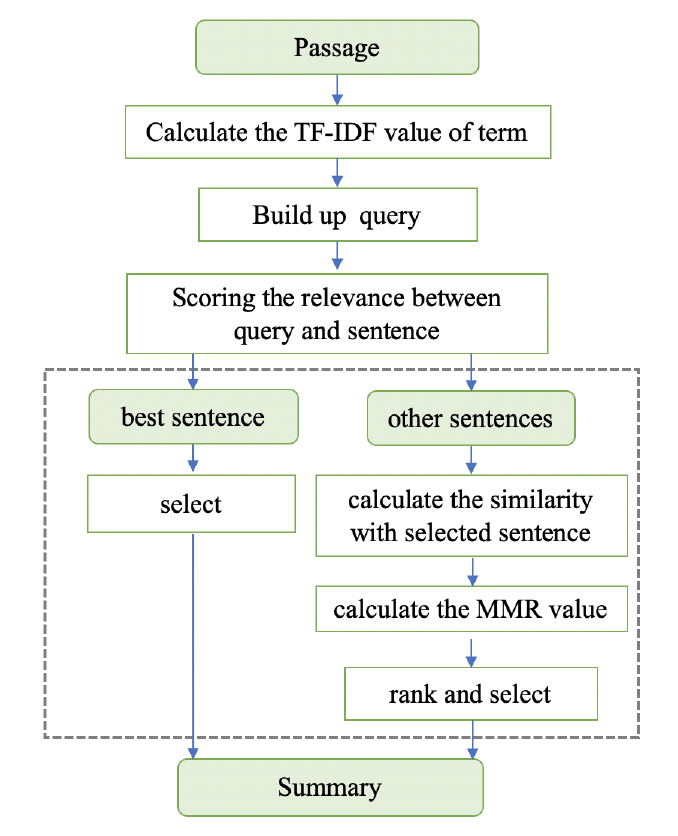
Figure 3. The process of summary